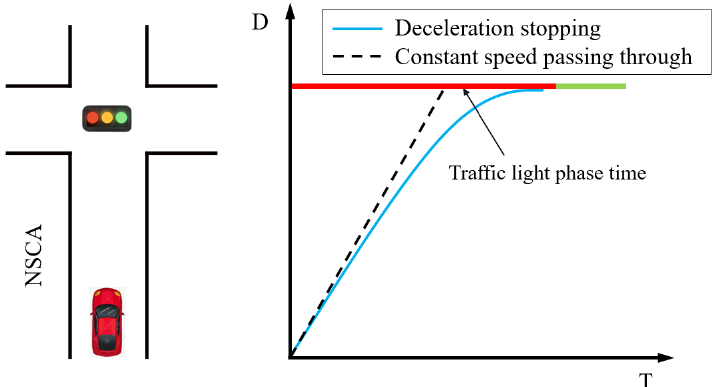
Figure 11. Red-light phase deceleration stopping.